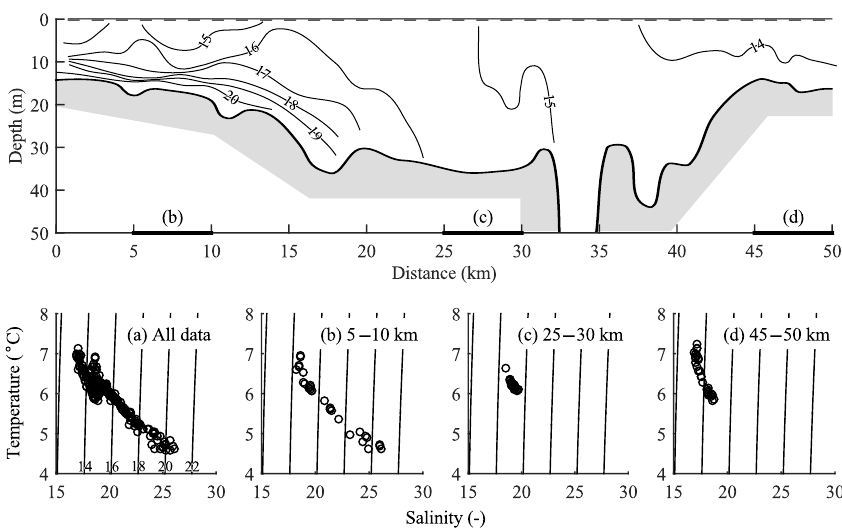
Figure 2. Along-strait transect of observations of density (minus 1000kgm − 3 ) given by contour lines (upper panel), and the distributions of salinity (in Practical Salinity Units) and temperature of the entire transect (a) , at 5–10km (b) , at 25–30km (c) , and at 45–50km (d) . In the salinity–temperature plots the lines are contours of constant density (minus 1000kgm − 3 ). The observations were made using a ScanFish (see text), the entire transect corresponding to more than 40 undulations from surface to bottom. The transect was made on 14 April 2004 between 09:10 and 15:07UTC along the long survey line shown Fig. 1, the length of the transect being measured from the northern